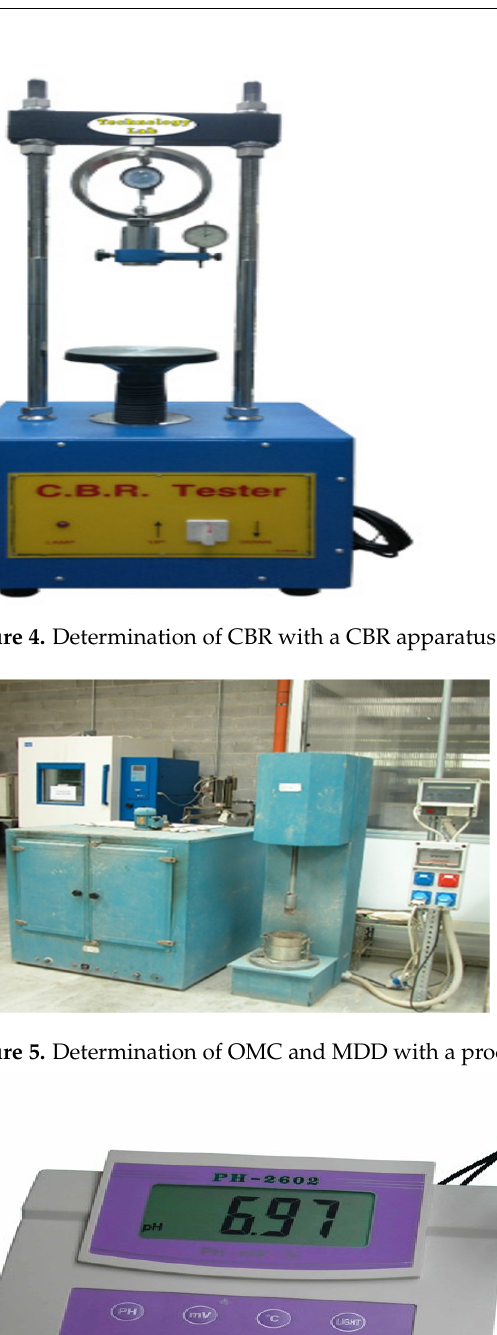
Figure 4. Determination of CBR with a CBR apparatus.